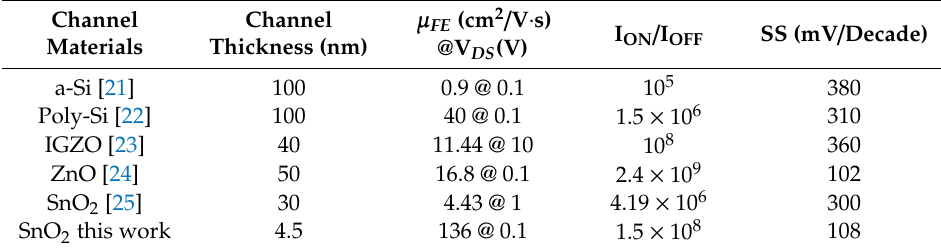
Table 1. Important device performance comparison of various top-gate TFT devices on SiO 2